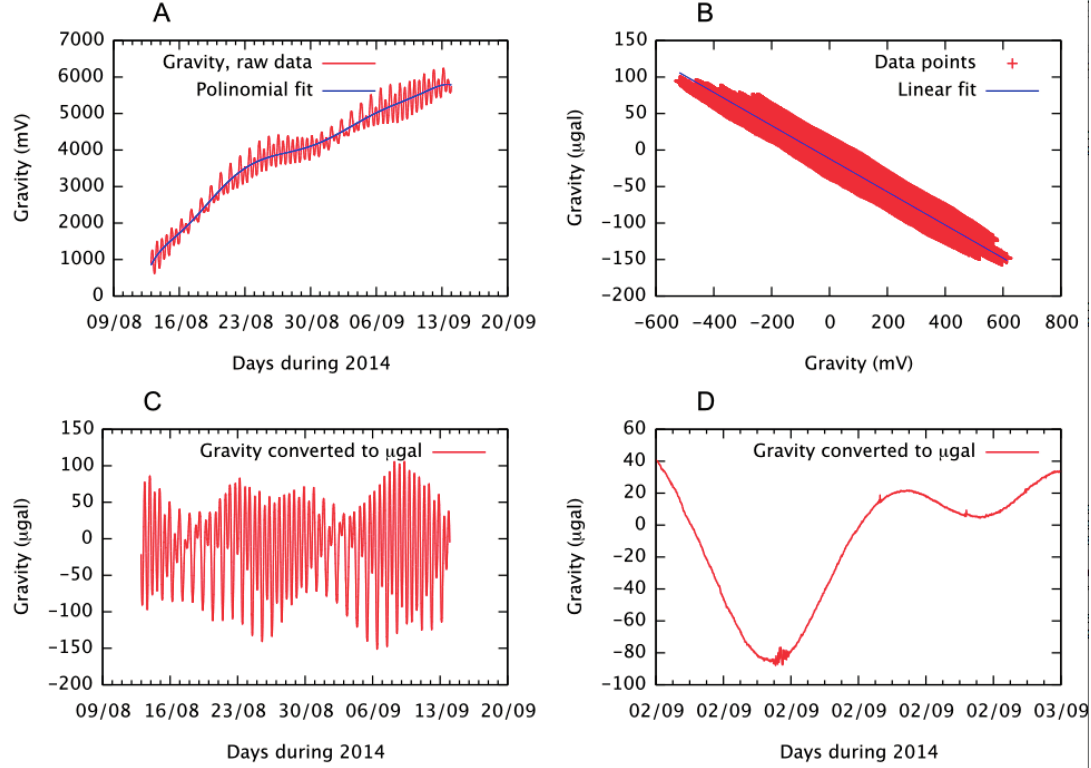
Figure 12. ( A ) Graph of the registered gravity and the trend curve; mV are plotted against days; ( B ) Graph of the adjustment of the line of the points obtained from the theoretical gravity (µgal) and experimentally obtained values (mV); ( C ) Graph of the gravity converted to µgal; ( D ) Detail of the previous graph in which the effect of a distant earthquake is